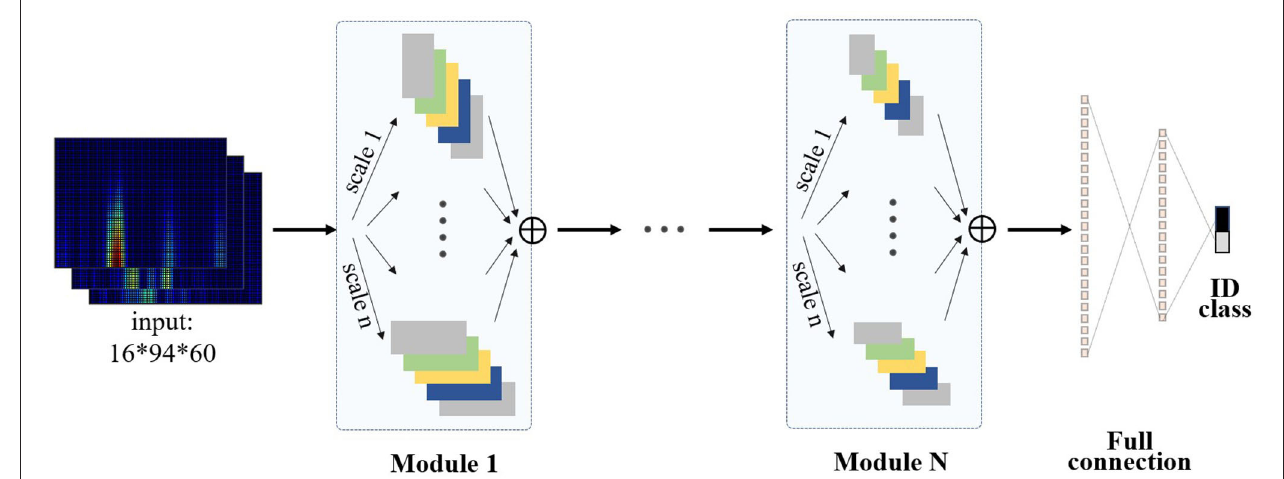
FIGURE 5 | 3D Multi-scale convolutional framework for EEG